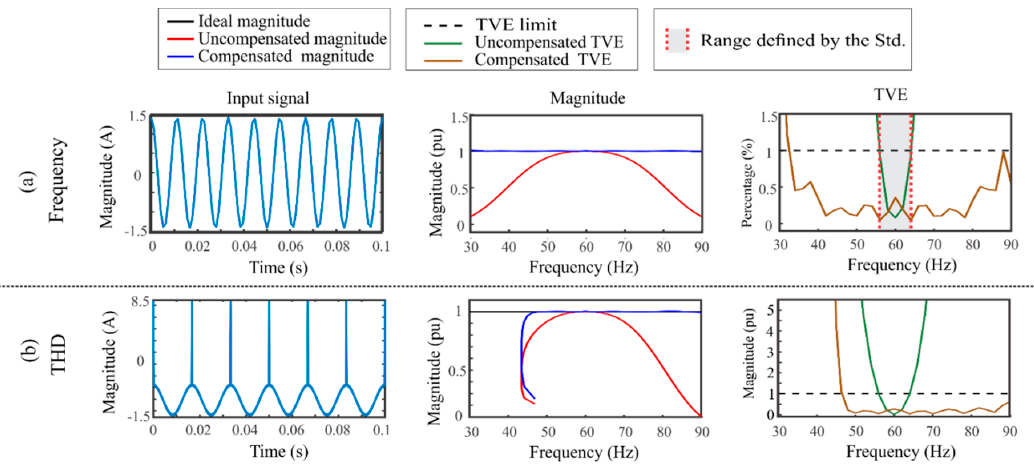
Figure 9. Experimental tests in steady-state: ( a ) Static changes frequency and ( b ) Harmonic distortion test.